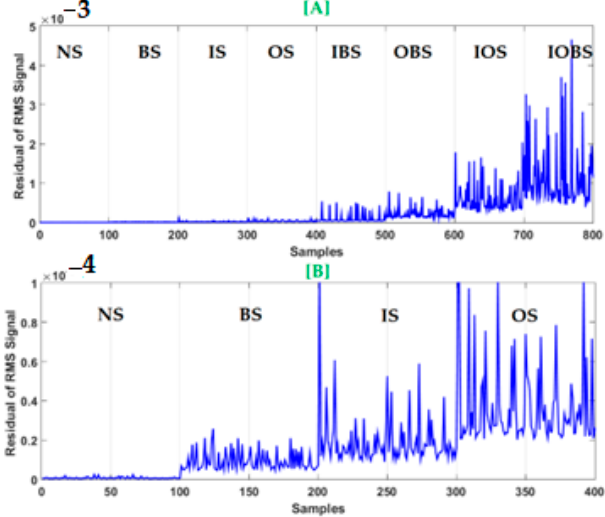
Figure 9. Residual RMS signal using proposed smooth sliding digital twin. ( A ) all conditions, ( B ) zoom view for four conditions.